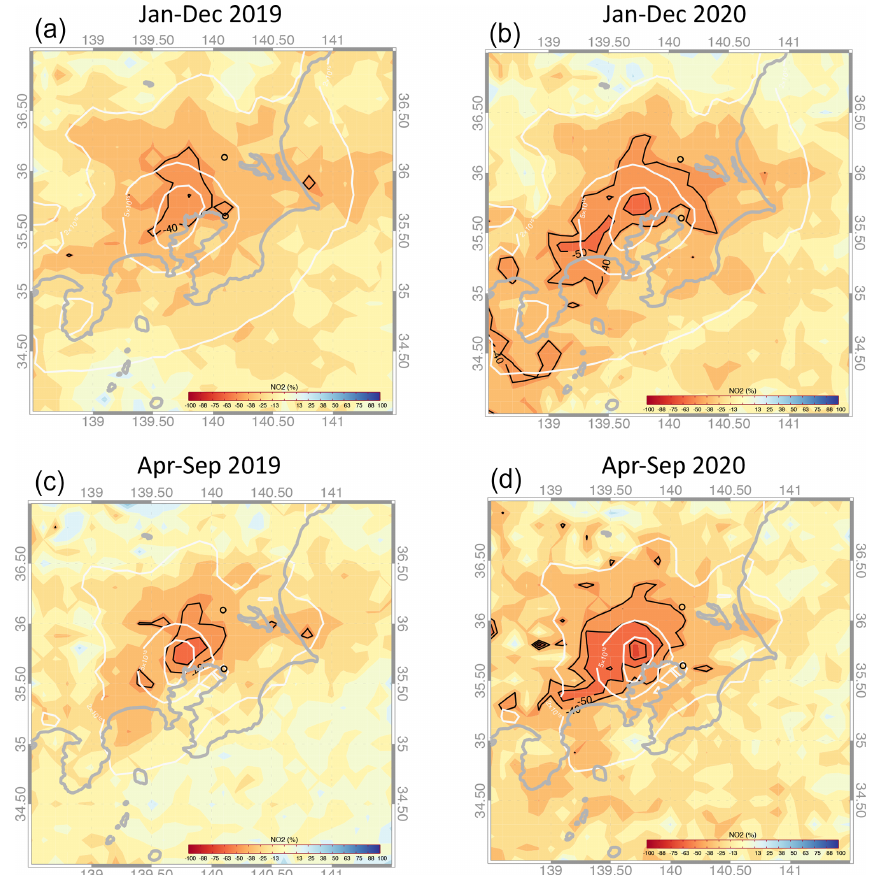
Figure 8. Spatial distribution of the TROPOMI NO 2 weekend effect (Sunday minus weekdays) in January to December 2019 (a) , January to December 2020 (b) , April to September 2019 (c) , and April to September 2020 (d)